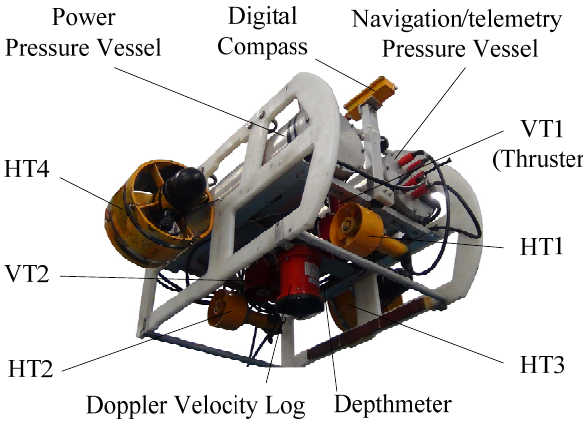
Figure 8. Physical layout of the AUV. The experimental process is described as follows. The target surge speed of the AUV is set at u T m/s. AUV starts from 0 m/s. The fault of HT3 occurs at time step 250 and continues to the end of the experiment. The percentage of thrust loss is set at λ %. The thruster fault is simulated by decreasing the control voltage which is actually loaded to the thruster driver. The experimental data including the control voltage for main thrusters and the surge speed of AUV is recorded at 5 Hz. The target surge speed u T is 0.2 m/s, 0.3 m/s, 0.4 m/s, and 0.5 m/s, respectively. The λ % is 0%, 10%, 20%, 30%, and 40%, respectively. The experimental data under a target surge speed of 0.3 m/s and with a percentage of thrust loss of 30% is taken as an example, as shown in Figure 9.